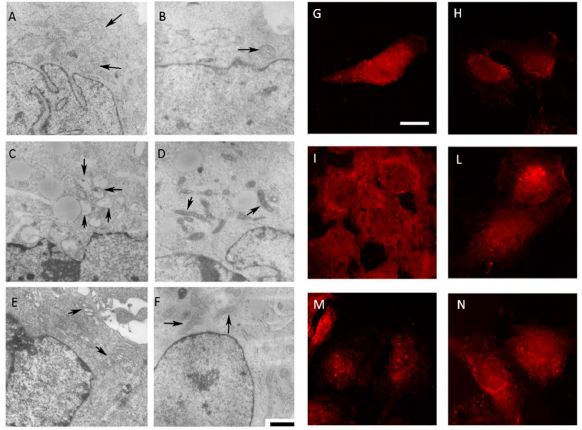
Figure 6. (1) Representative electron micrographs of Daoy cells incubated for 48 h in complete medium with Simvastatin (10 µ M) and Mevalonate (10 mM) in the presence or absence of GGOH (50 µ M) for 24 h. For each picture, an enlargement of the image is displayed, showing the presence of normal or damaged mitochondria (indicated by arrowheads). Scale bar, 1 µ m; (2) Confocal microscopy of Daoy cells after different treatments stained with Mito-ID (red fluorescence). Many fields were examined and over 95% of the cells displayed the patterns of the respective representative cells shown here. Scale bar, 20 µ m. ( A , G ) untreated condition; ( B , H ): GGOH treatment; ( C , I ): Simvastatin treatment; ( D , L ) Simvastatin + GGOH treatment; ( E , M ): Mevalonate treatment; ( F , N ): Mevalonate + GGOH treatment.